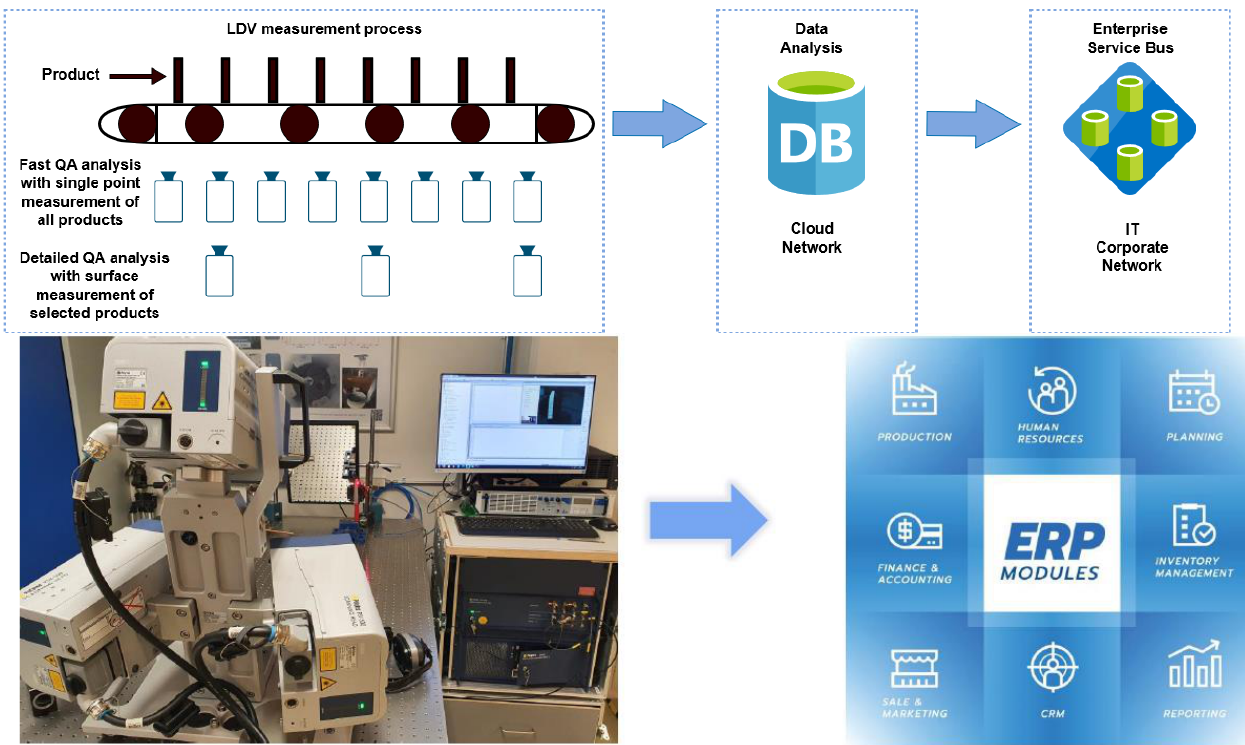
Figure 10. Incorporation of 3D LDV in QA and QC for Industry 4.0.